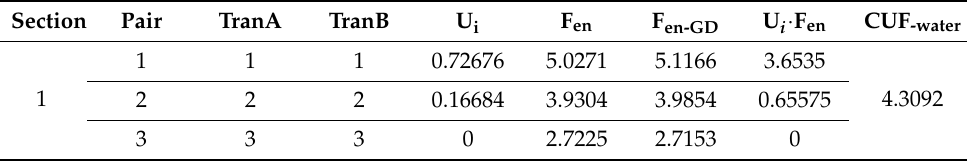
Table 2. Environmental fatigue calculation results of sample problem